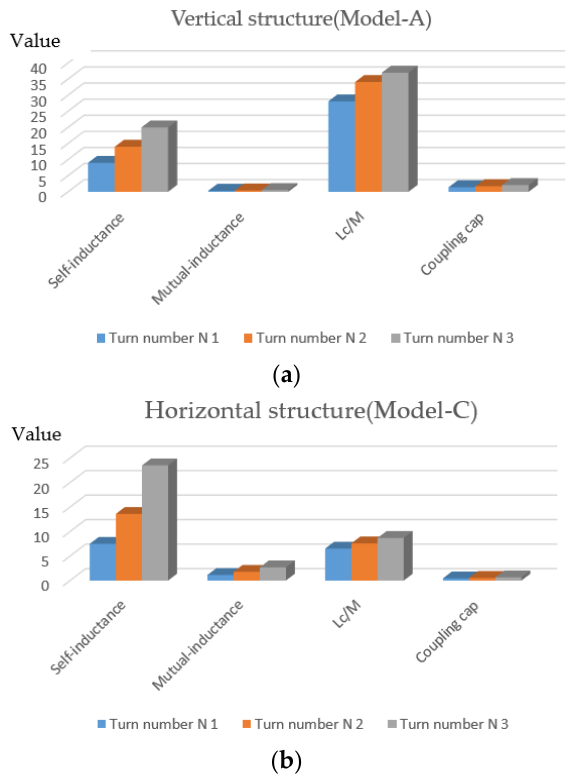
Figure 11. FEM results under different turn-numbers: ( a ) vertical structure coil model and ( b ) horizontal structure coil model.